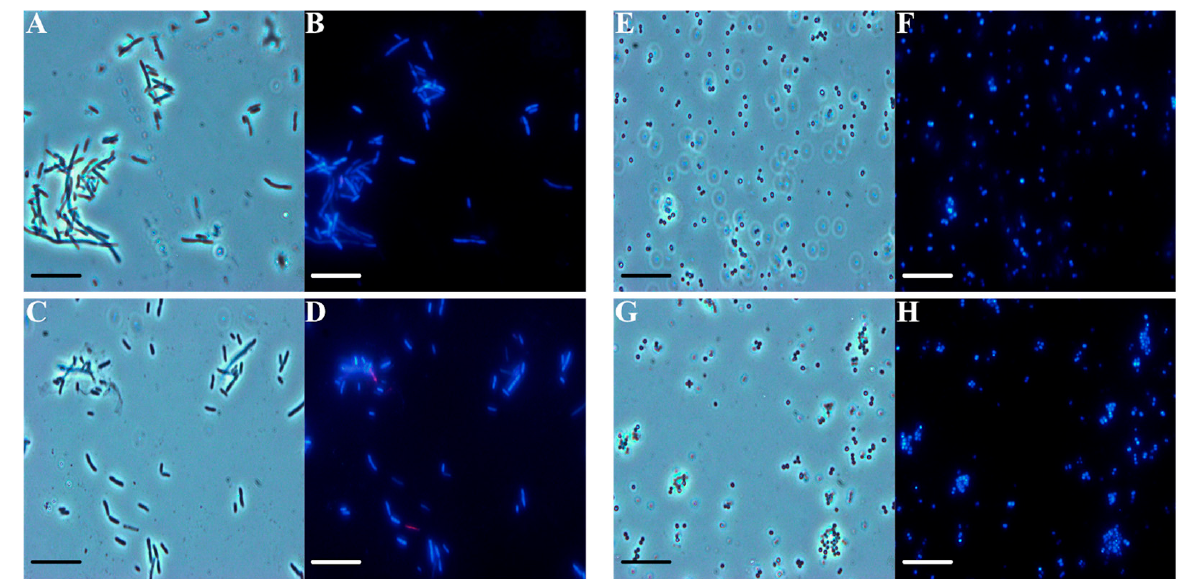
Figure 4. Evaluation of the antimicrobial action mechanism of F. vulgare subsp. vulgare var. vulgare EO, by fluorescence microscopy. Panels show E. coli bacterial cells ( A – D ) and S. aureus bacterial